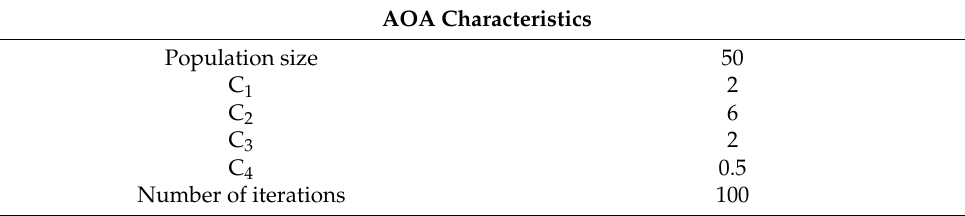
Table 1. AOA characteristics.